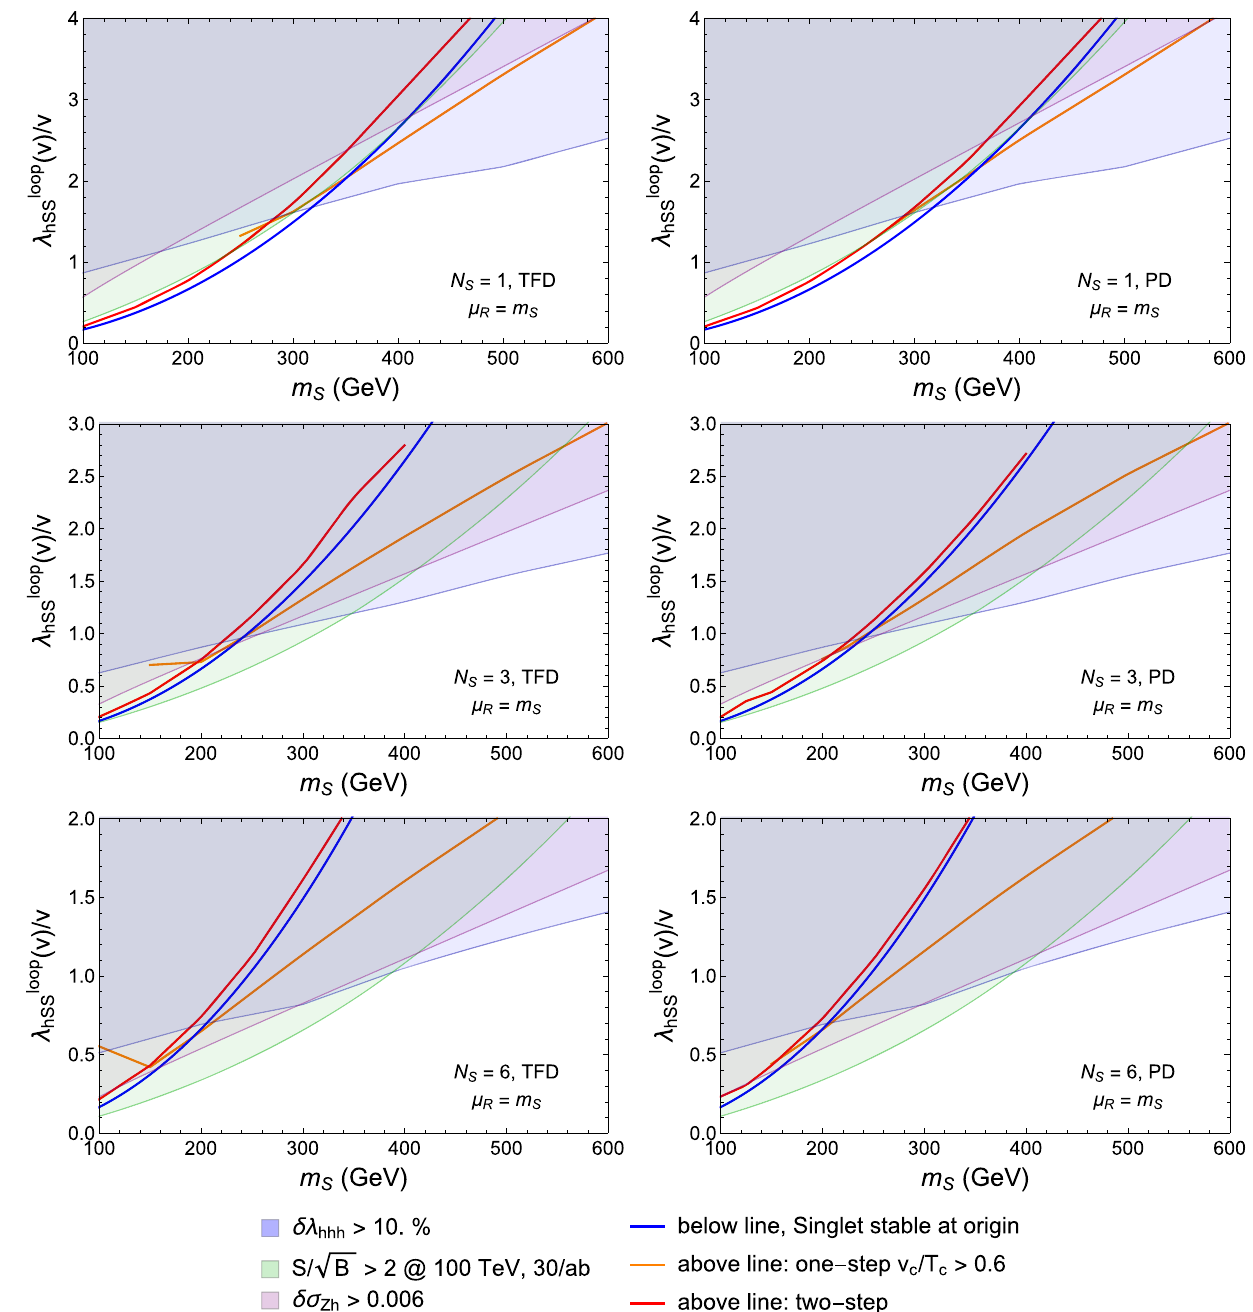
Fig. 6 Phenomenological parameter space of the SM + N S × S bench- mark model of EWBG, for N S = 1 , 3 , 6, computed in the TFD or PD thermal resummation scheme. The physical singlet mass in our EWSB vacuum is on the horizontal axis, the higgs-singlet cubic coupling is on the vertical axis. This determines most collider observables. The Higgs cubic coupling deviation Eq. (4.5) is bigger than 10% in the blue shaded region , to which a 100 TeV collider with 30 ab − 1 has more than 2 σ sensitivity [97]. For the same luminosity, a direct VBF + MET